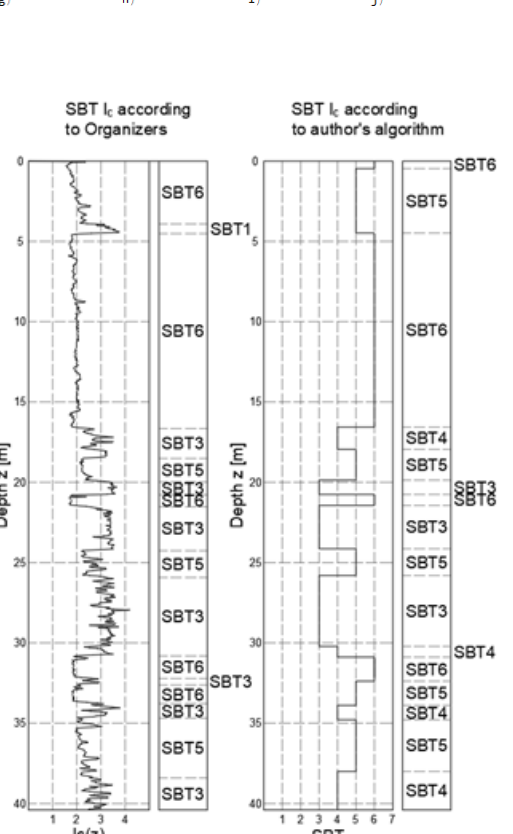
Figure 11: Comparison of stratification according to Organizers and